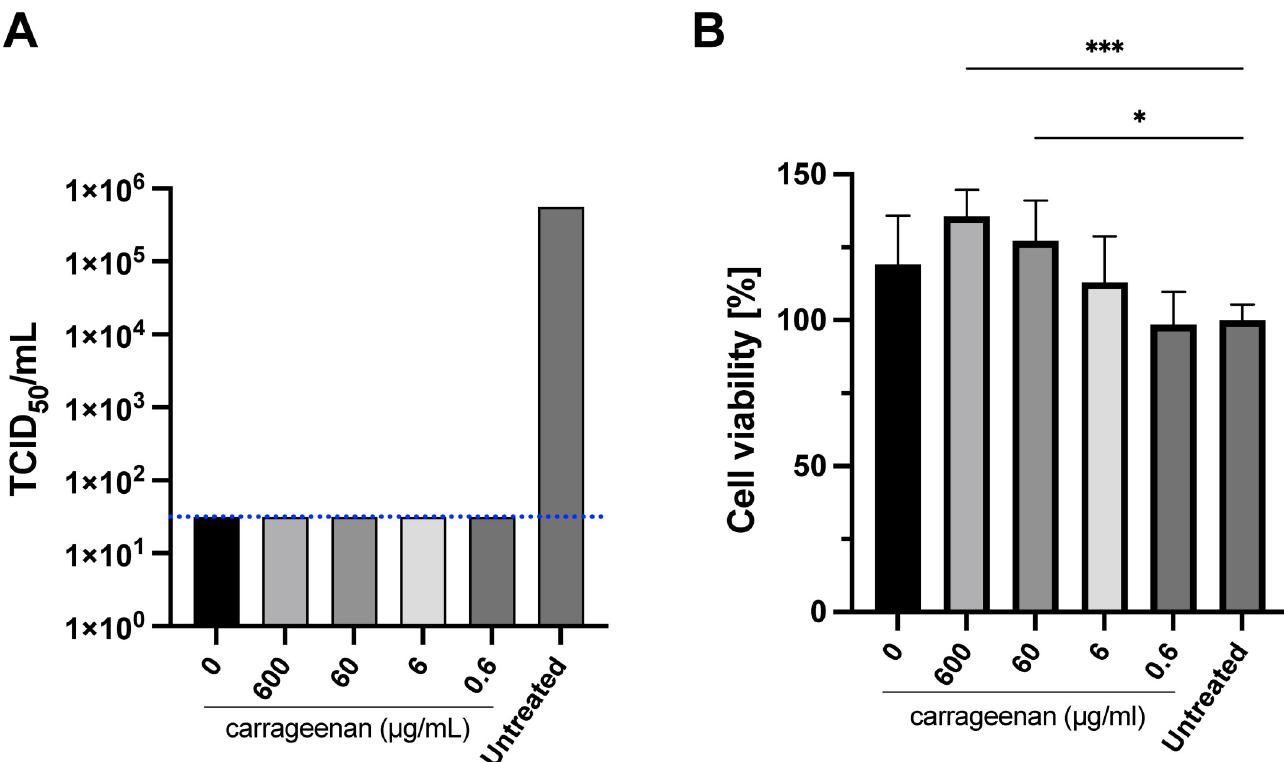
Fig 3. SARS-CoV-2 viral titer after treatment with Samples 3 and P3. A) Infection assay. Sample 3 composition: 1.2mg/mL iota-carrageenan, 5% m/V xylitol, pH 6–7. Vero E6 were pre-treated with dilutions of Sample 3 and Sample P3 (placebo without iota-carrageenan) to get 600 μ g/mL, 60 μ g/mL, 6 μ g/mL, and 0.6 μ g/ mL final iota-carrageenan concentration for two hours. After this pretreatment, cells were infected with SARS-CoV-2 and incubated for 48 hours in the presence of the same dilutions of Sample 3. Supernatants were harvested, and virus yield was determined by an endpoint dilution assay (TCID 50 ). Controls consisted of untreated infected cells or infected cells treated with P3 (no iota-carrageenan). Results were determined using the Reed and Muench formula and expressed as log TCID 50 /mL. The dotted line shows the limit of detection (LOD). Testing of samples was performed in triplicate and the p-value indicates that the groups are significantly different p = 0.0045, nevertheless no post-hoc analysis could be performed. B) Cellular viability assays. Vero-E6 cells were treated with iota- carrageenan or vehicle (600 μ g/mL to 0 μ g/mL) for 48 h at 37˚C. After incubation, cellular viability was analyzed. No statistically significant difference was found between compositions at low iota-carrageenan concentrations, 6 μ g/mL (p = 0.6904) and 0.6 μ g/mL (p > 0.9999) compared to the untreated control group (Group 6 μ g/ml, p = 0.6904, and Group 0.6 μ g/ml, p > 0.9999). Compositions with higher concentrations of iota-carrageenan tend to show a significant difference increasing cell viability (Group 600 μ g/ml, p = 0.0031 ( ��� ), Group 60 μ g/ml, p = 0.0417 ( � ), They are certainly not toxic, but may exert some cytoprotective effect.). Data are expressed as mean ±